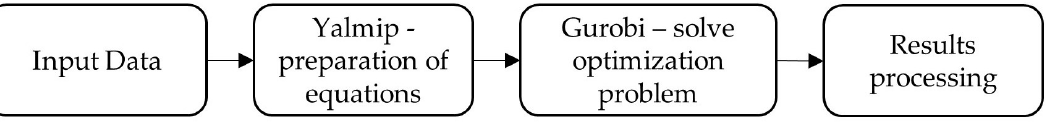
Figure A1. Optimization process.